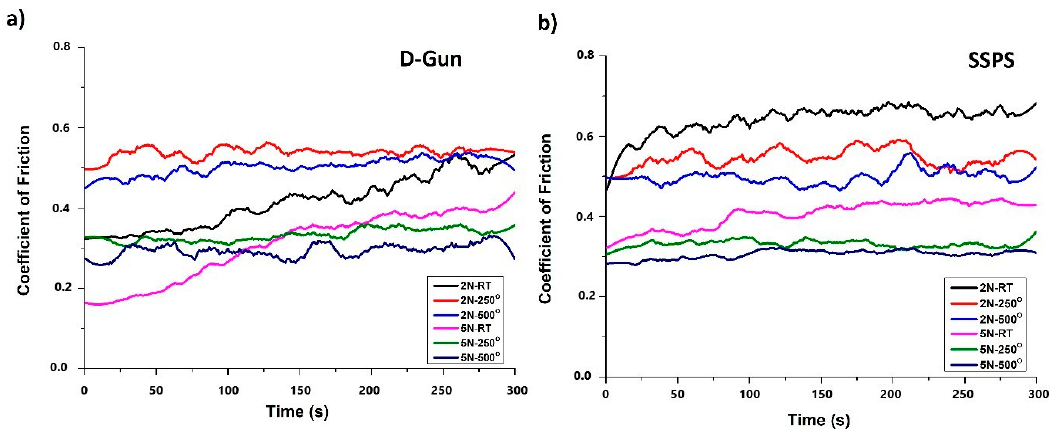
Figure 9. Coe ffi cient of friction curves of the coatings at di ff erent temperatures under 2 and 5 N loads: Figure 9. Coefficient of friction curves of the coatings at different temperatures under 2 and 5 N loads: ( a ) D-gun coating technique; ( b ) SSPS coating ( a ) D-gun coating technique; ( b ) SSPS coating technique.